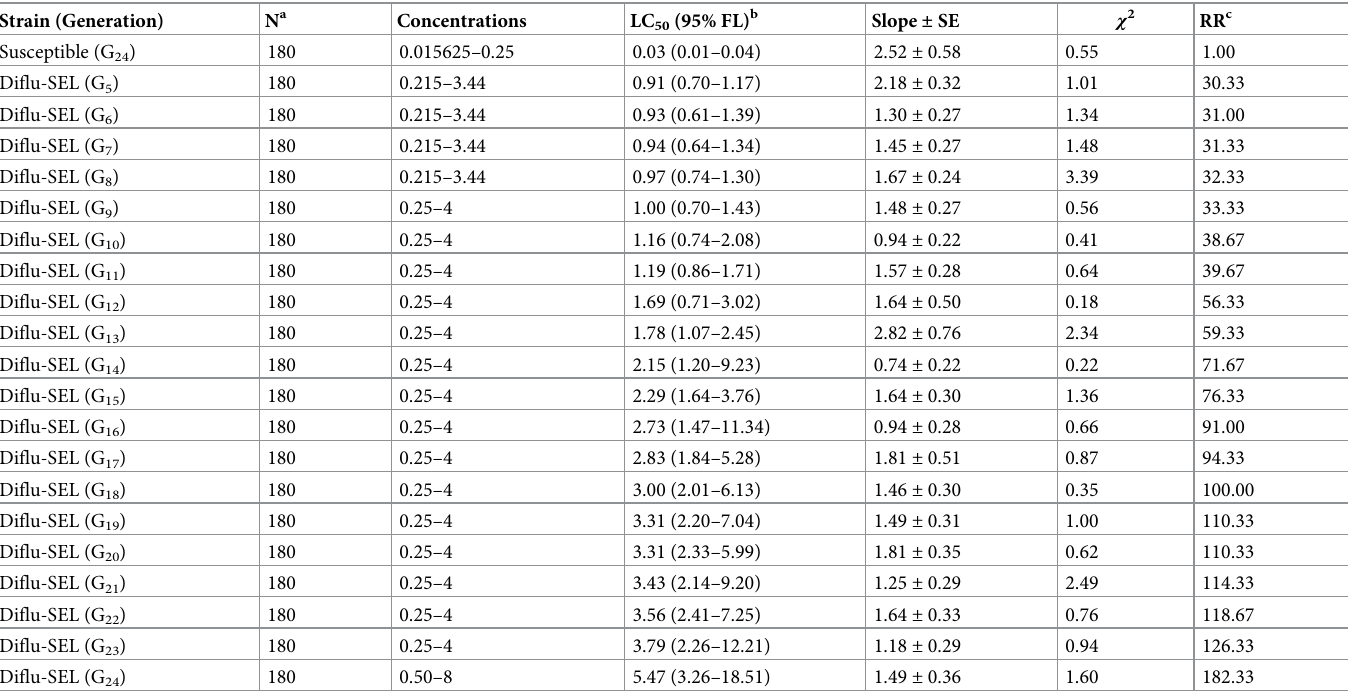
Table 3. Development of resistance to diflubenzuron in M . domestica . Strain (Generation)